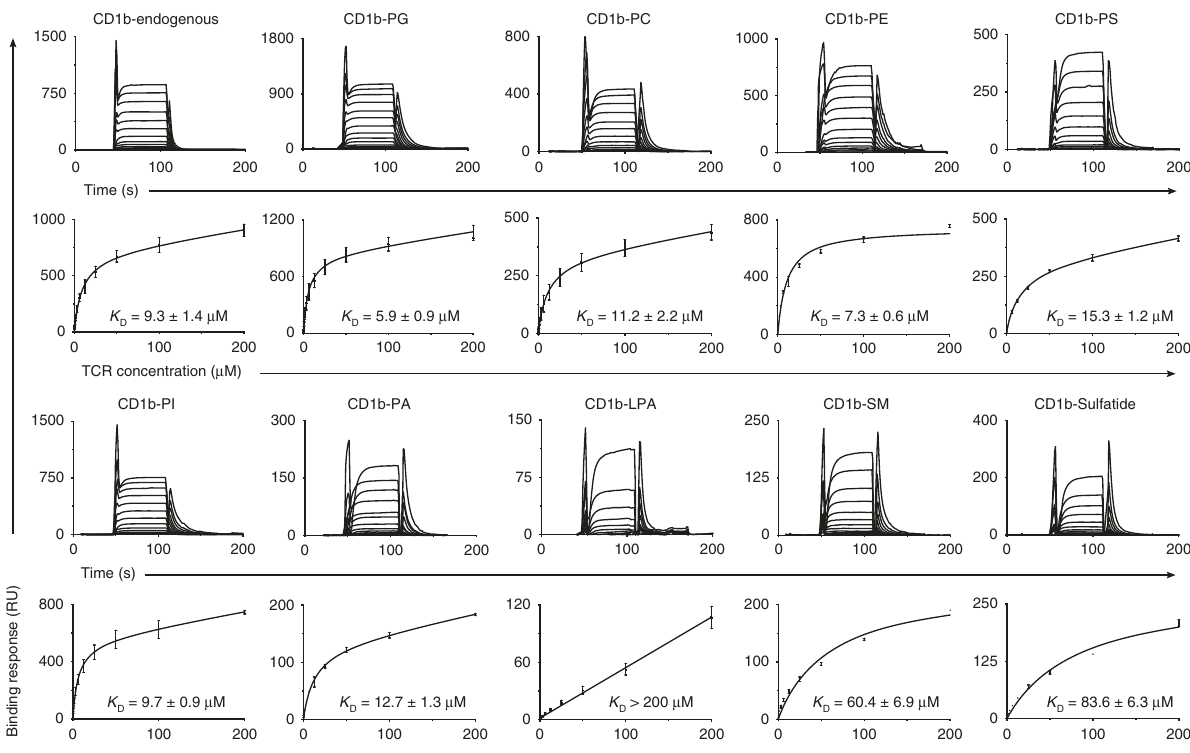
Fig. 3 Steady-state af fi nity measurements of BC8B TCR against CD1b by SPR. Steady-state af fi nity measurements by SPR of the BC8B TCR against CD1b presenting a range of phospholipid and non-phospholipid antigens. Three (CD1b-endo, CD1b-PS, and CD1b-PC) or two independent (all other antigens) SPR experiments were conducted. Steady-state ( K D ) values and error bars represent mean + SEM in μ M of duplicate measurements. Sensograms (upper) and equilibrium curves (lower) were generated in Graphpad Prism